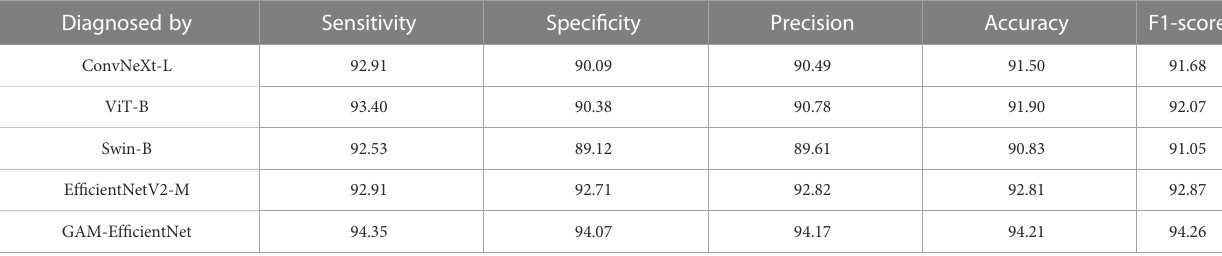
TABLE 2 Diagnostic performance of fi ve models on the internal test set (n%).